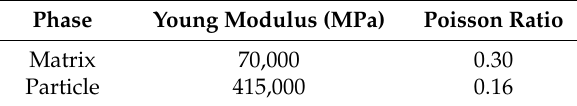
Figure 12. Geometrical models of: ( a ) equivalent inclusion problem for cubic particle (view on one eight of model) ( b ) representative volume element of composite reinforced with 15% of cubic particles. Table 5. Elastic properties of matrix and particle.